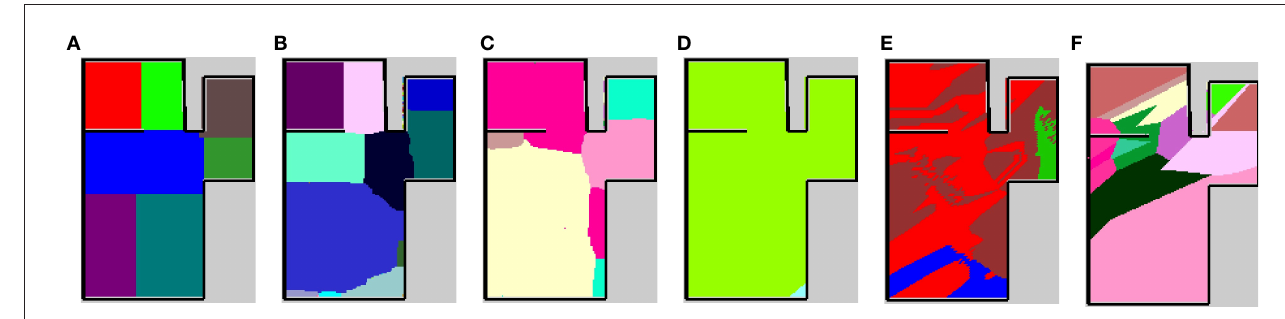
FIGURE 7 | Semantic maps of the experiment in simulation environment Room1ldk4. (A) The map of ground truth drawn manually, (B) the map of SpCoMapping when the number of spatial concepts are unknown, (C) map of SpCoMapping when the number of spatial concepts are known, (D) map of the existing spatial concept acquisition method (Ishibushi et al., 2015), (E) map of the CNN-based semantic mapping (Sünderhauf et al., 2016), and (F) map of nearest neighbor. The colors represent different categories on each map.